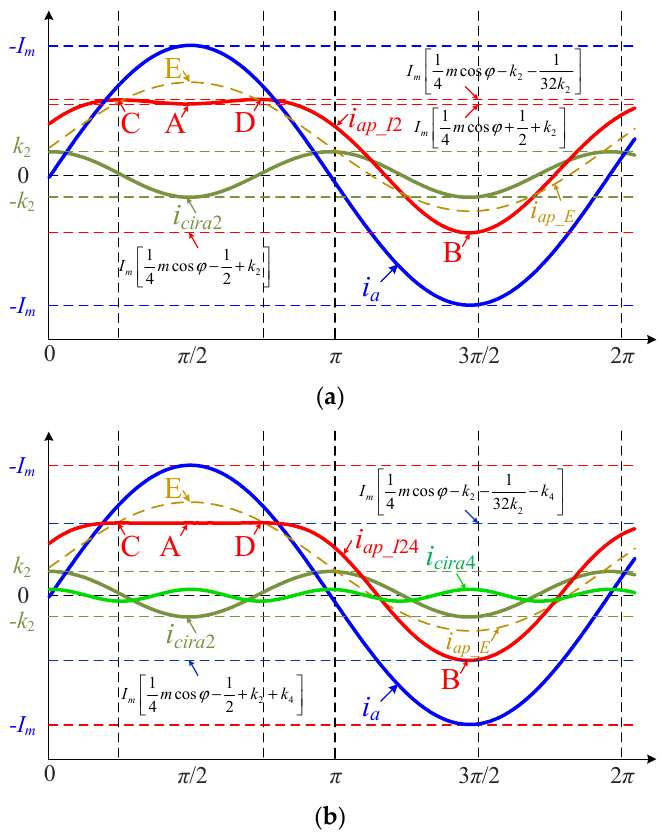
Figure 3. Schematic diagram of the arm current of the MMC using the CCIC scheme in the inverter mode: ( a ) single injection of SOCC; ( b ) joint injection of SOCC and FOCC.